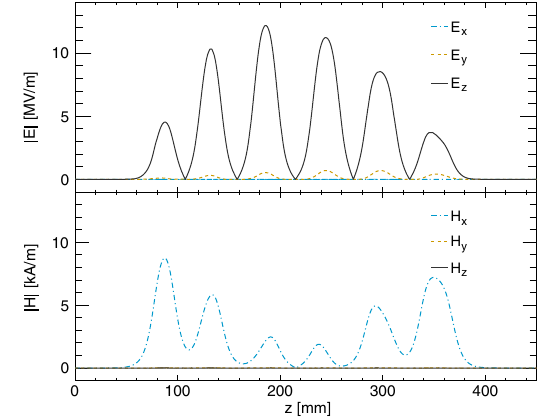
TABLE II. Comparison of the full IH and short